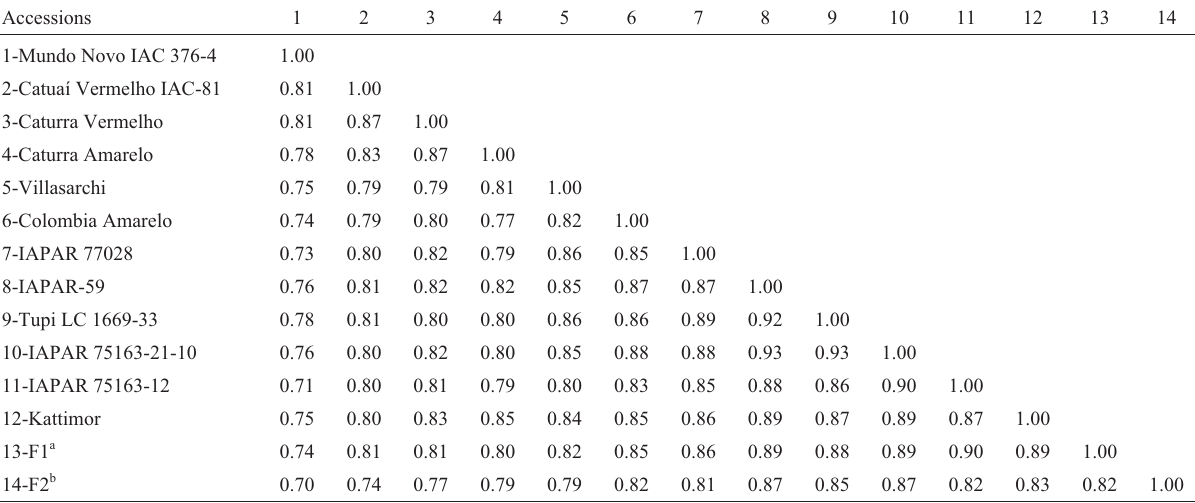
Table 2 - Genetic similarity based on the Dice coefficient applied to 14 C. arabica cultivars